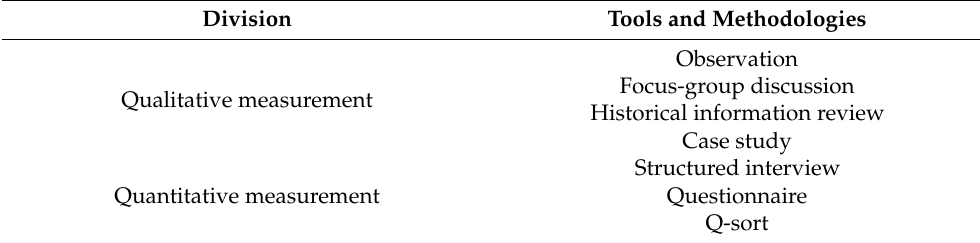
Table 1. Measurement of safety culture (Source: adapted from